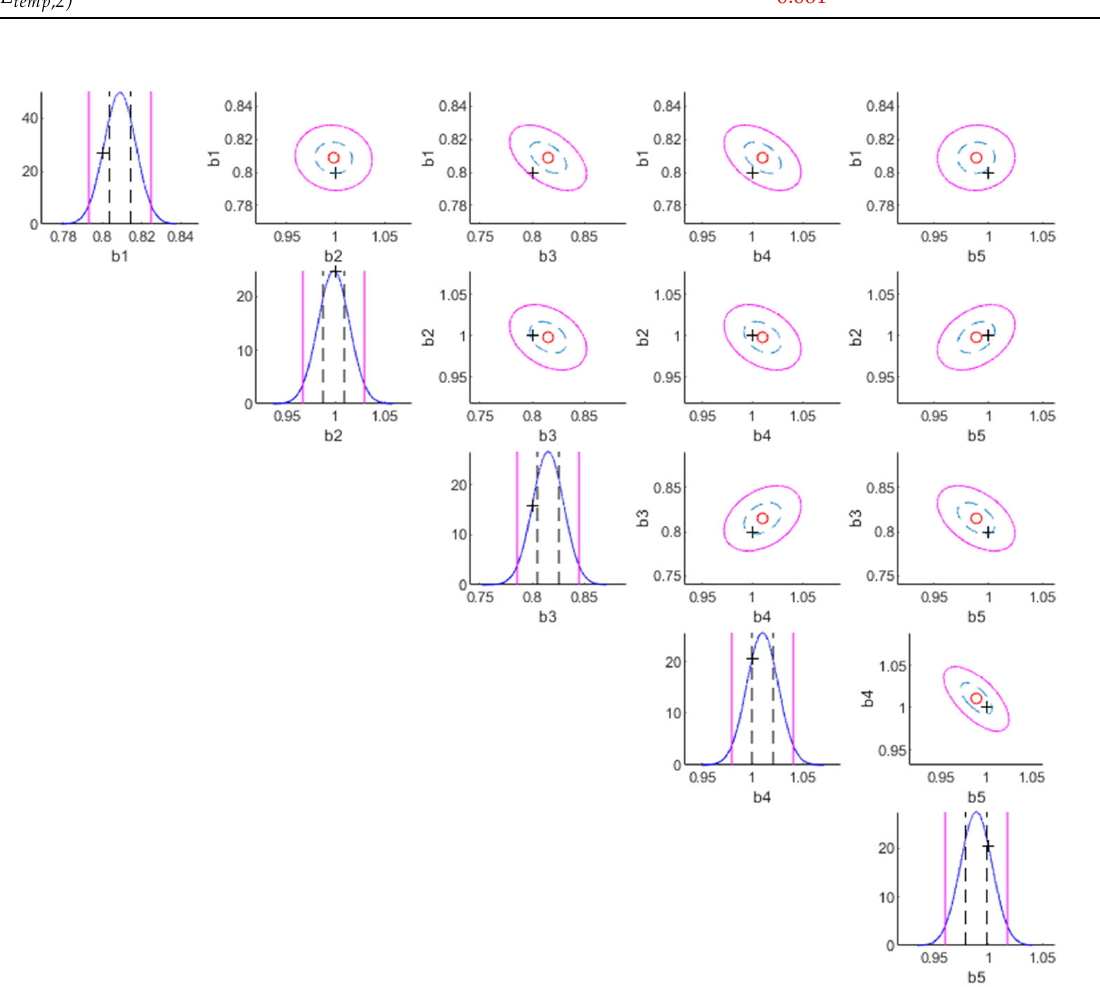
Figure 3. Contour plot of the posterior PDF of the substructure parameters of the most plausible model class (damaged case).